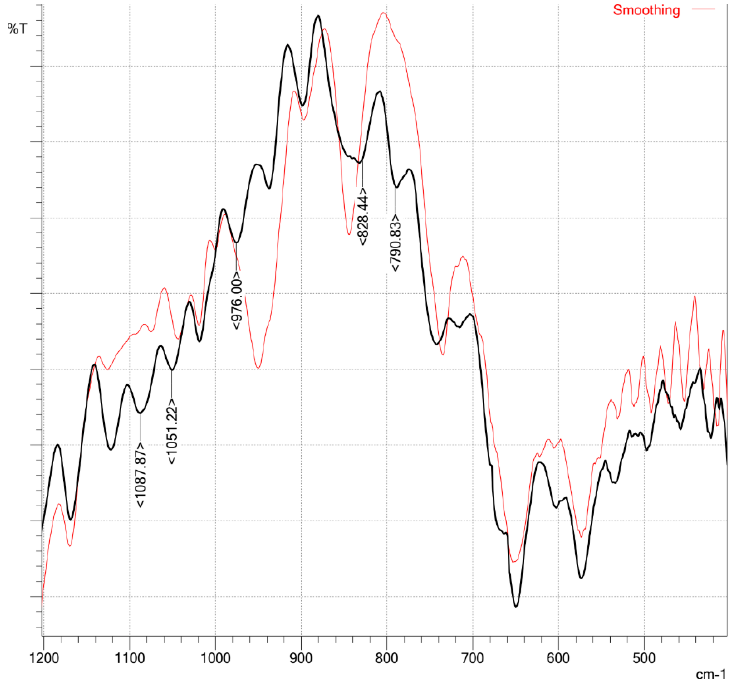
Figure 7. IR-spectra (KBr pellets) of 1—VP–VDTC (red); 2—VP–VDTC–In (black).